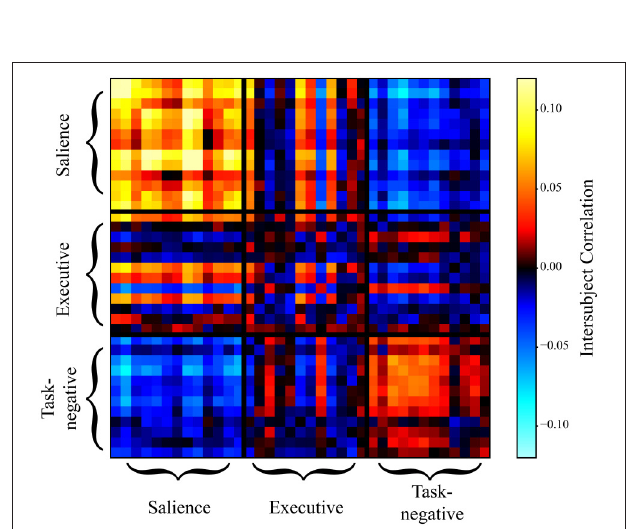
FIGURE 9 | Intersubject correlation matrix during approach when both positive and negative weights were simultaneously considered (no thresholding). Weights between the salience and task-negative networks were predominantly negative, indicating that they were inversely related during approach. For simplicity, all data points during individual approach segments were averaged; likewise, during individual retreat segments.